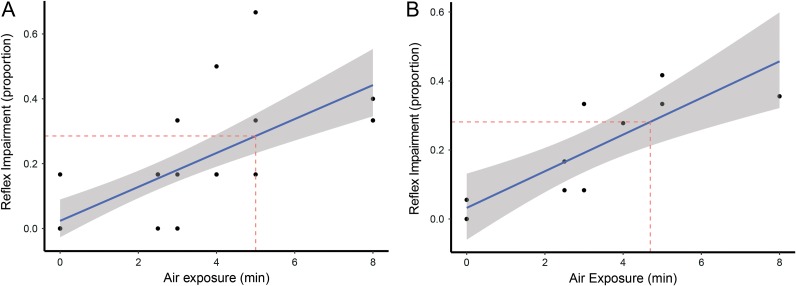
(A) Linear regression model fitted to air exposure (min) and reflex impairment (proportion). Points are individual fish impaired reflex scores at given air exposures. (P < 0.001, n = 32). Gray area around fitted line represents 95% confidence interval. Dashed red line represents the median lethal dose of reflex impairment and the corresponding air exposure. (B) Linear regression model fitted to air exposure (min) and reflex impairment (proportion). Points are group averages of impaired reflex scores at given air exposures. (P < 0.001, n = 11). Gray area around fitted line represents 95% confidence interval. Dashed red line represents the median lethal dose of reflex impairment and the corresponding air exposure.